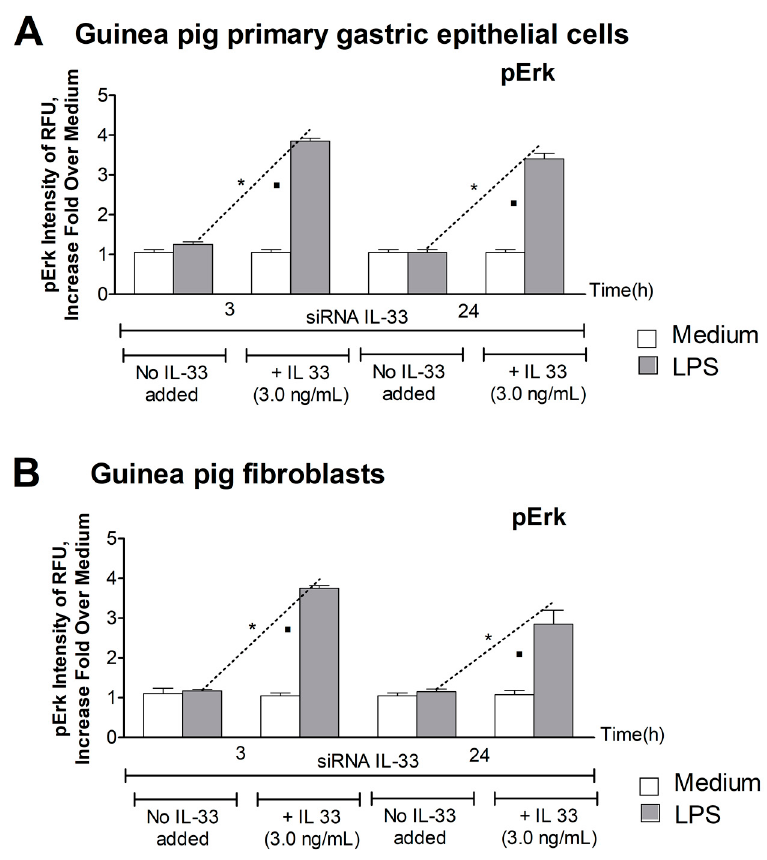
Figure 3. Activation of Erk. The level of activated–phosphorylated Erk (pErk) was estimated in cell cultures of guinea pig primary gastric epithelial cells ( A ) or fibroblasts ( B ), transfected with siRNA IL-33, and then exposed or not exposed to H. pylori lipopolysaccharide (LPS), in medium with or without IL-33. Activation of Erk was estimated after 3 h and 24 h on the basis of the relative fluorescence units (RFU) of cells intracellularly stained for pErk with anti-pErk antibodies. Fluorescence was measured in a fluorescence reader (Victor2, Wallac, Oy Turku, Finland) at the following wavelengths: 495 excitation and 519 emission. Results are shown as Fold Over Medium calculated based on fluorescence intensity. Five experiments were performed in triplicate for each experimental variant. Statistical analysis was performed using the nonparametric Mann-Whitney U test with significance at p < 0.05. * cells exposed to LPS H. pylori in medium without IL-33 vs. cells exposed to LPS H. pylori in medium with IL-33; (cid:110) cells not treated with LPS H. pylori , sub-cultured in medium without